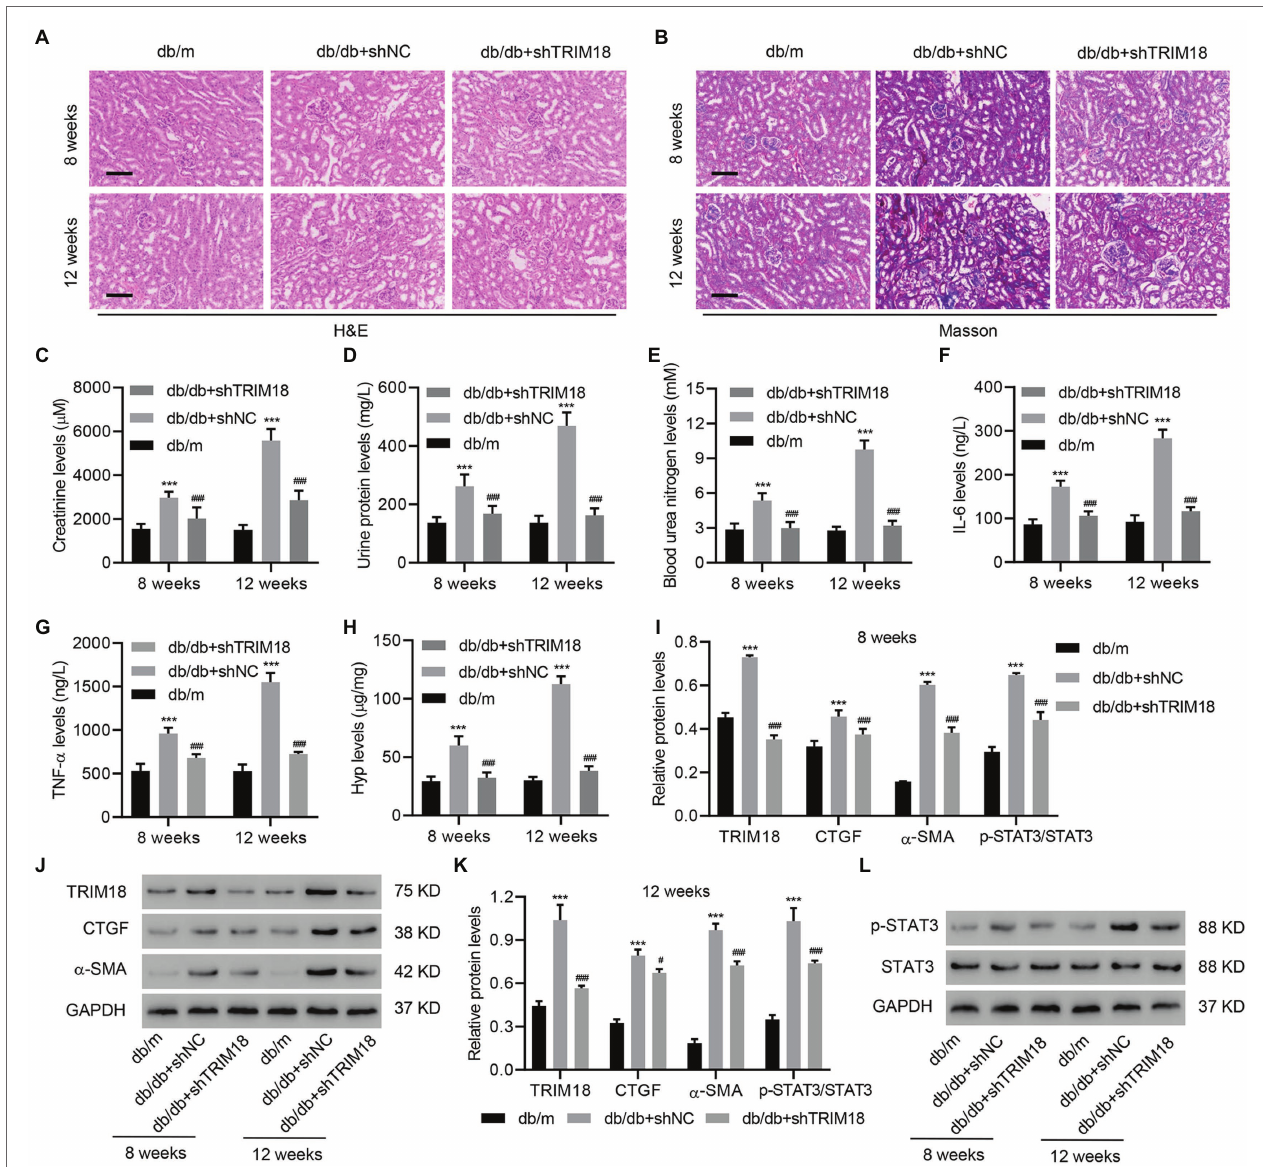
FIGURE 2 | The involvement of TRIM18 in db/db mice. (A) H&E and (B) Masson’s trichrome staining of the kidney tissues of db/m, db/db+shNC, and db/ db+shTRIM18 mice. Scale bar: 100 μ m. (C) Creatinine, (D) urine protein, (E) blood urea nitrogen, (F) IL-6, (G) TNF- α , and (H) Hyp levels of mice. (I–L) Expression of p-STAT3, TRIM18, CTGF, and α -SMA in mice. Values are presented as mean ± SD. n = 6/group. # p < 0.05 vs. db/db + shNC. *** p < 0.001 vs. db/m. ### p < 0.001 vs.